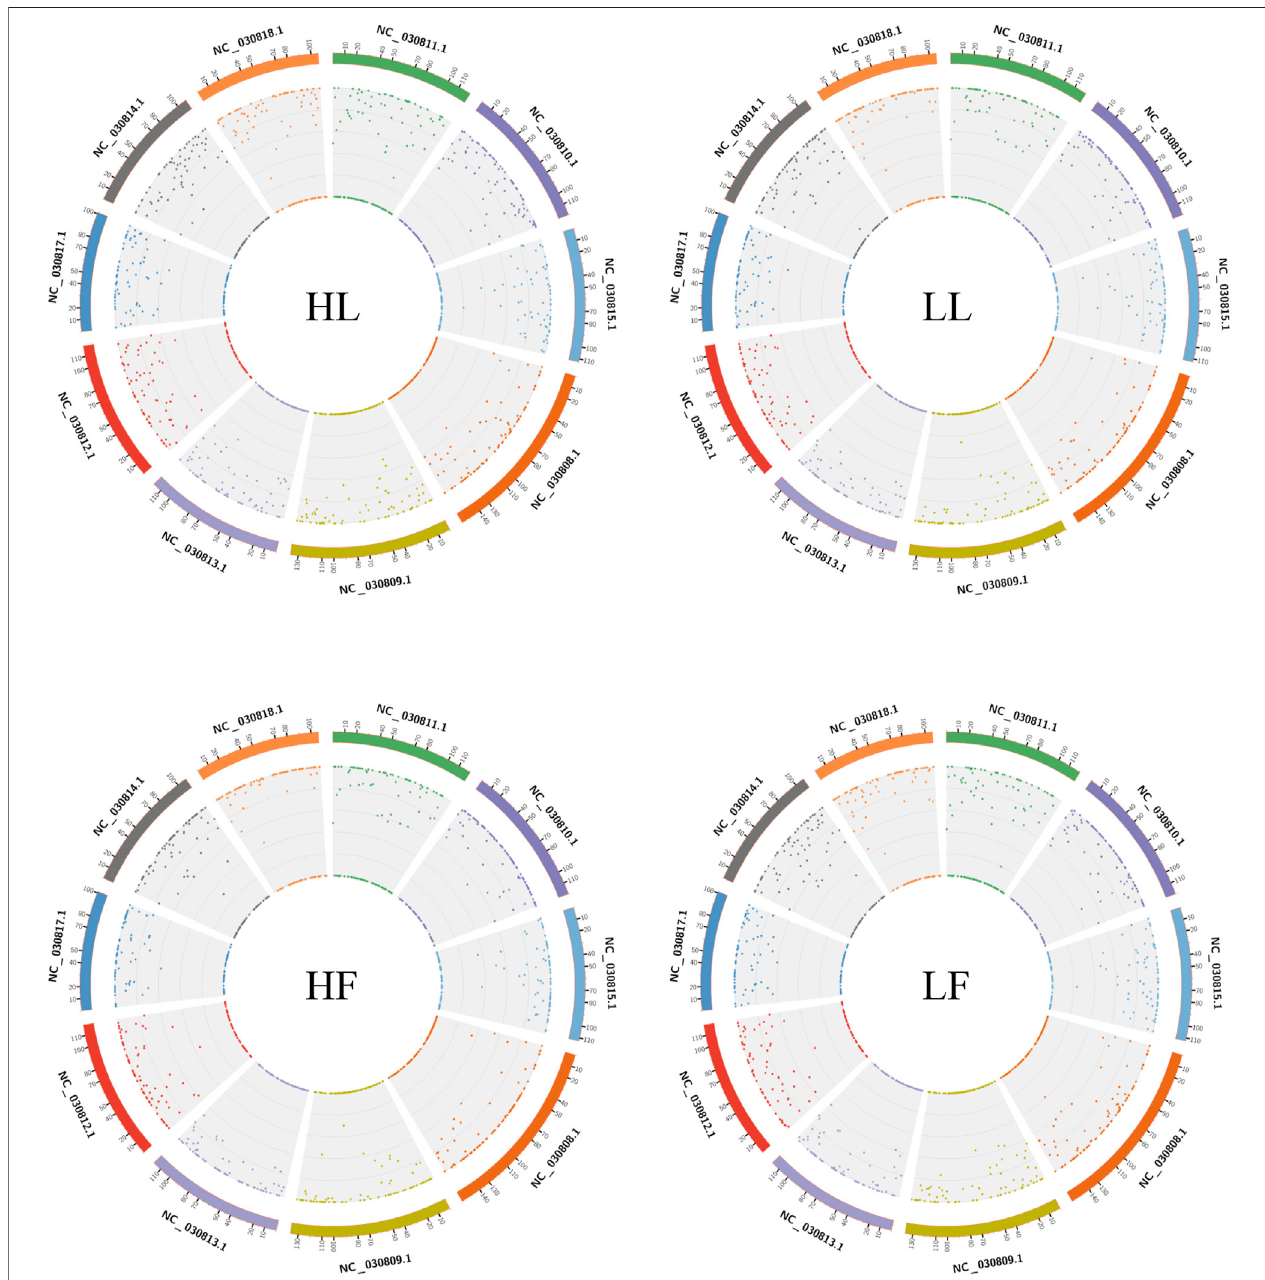
FIGURE 2 | Density statistics of circRNAs in chromosomes in the four groups. HL: high fecundity goats in the luteal phase; LL: low fecundity goats in the luteal phase; HF: high fecundity goats in the follicular phase; LF: low fecundity goats in the follicular phase.